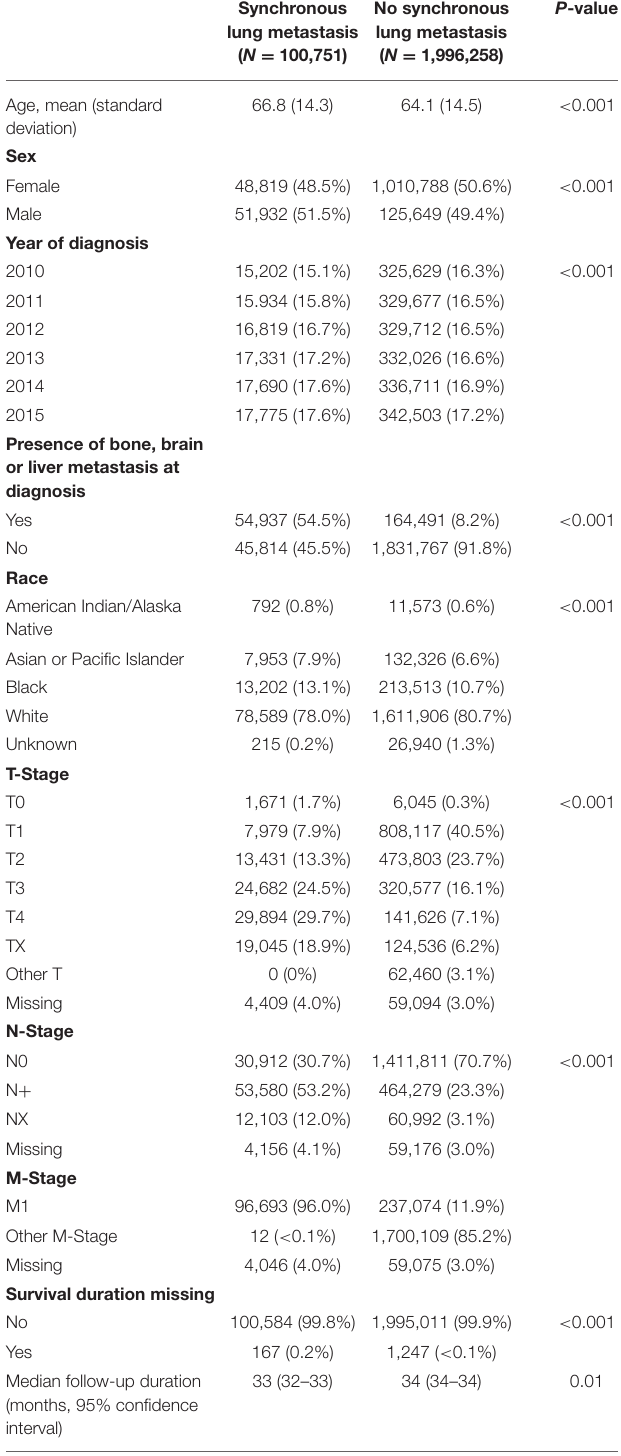
P-valuesrepresentresultsfromt-tests,chi-squaredtestsorlog-ranktestsforcontinuous, categoricalandtimetoeventvariables,respectively,whereappropriate.T-Stage,N-Stage, and M-Stage represent those from the American Joint Committee on Cancer 7th Edition Staging